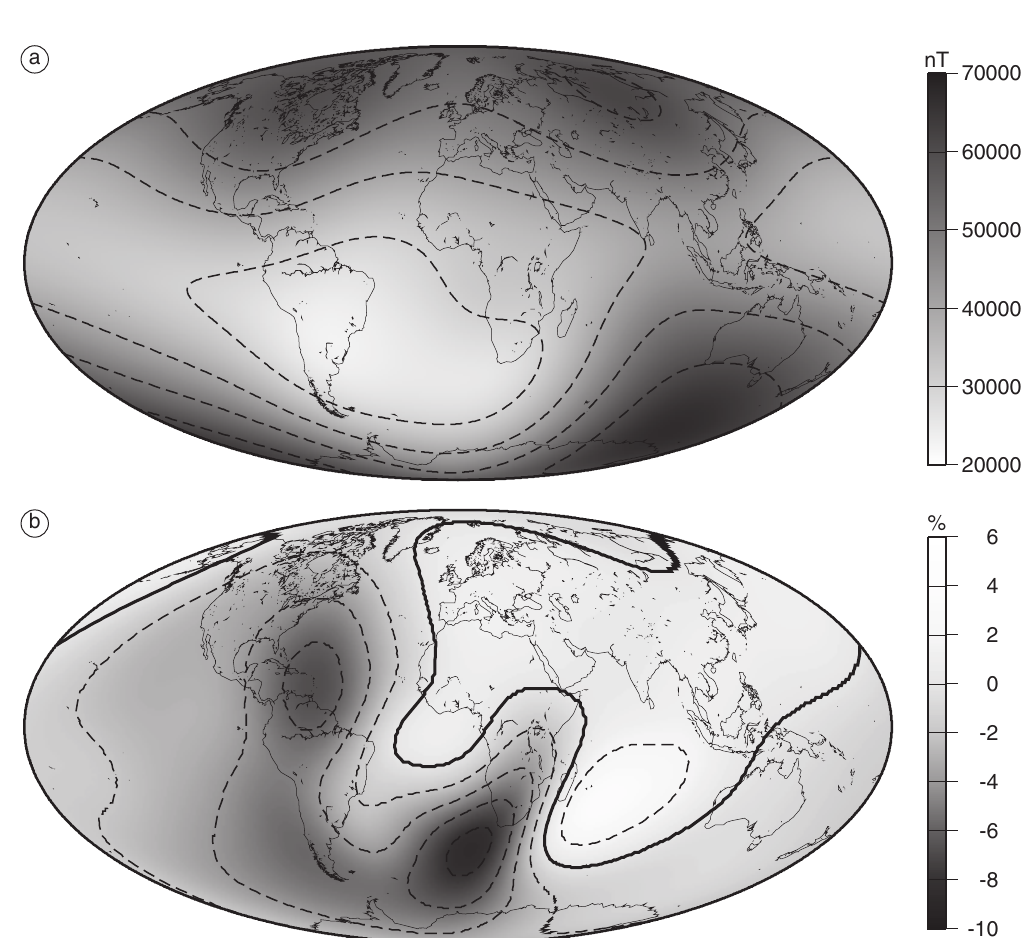
Fig. 1a,b. a) Global map of magnetic field intensity. The region of weakest intensity is known as South Atlantic Anomaly. (GRIMM Model, (Lesur et al ., 2008) b) Change of field intensity between 1979.85 and 2003.5 in per- cent (Difference between GRIMM and a model from MAGSAT data (Langel et al .,